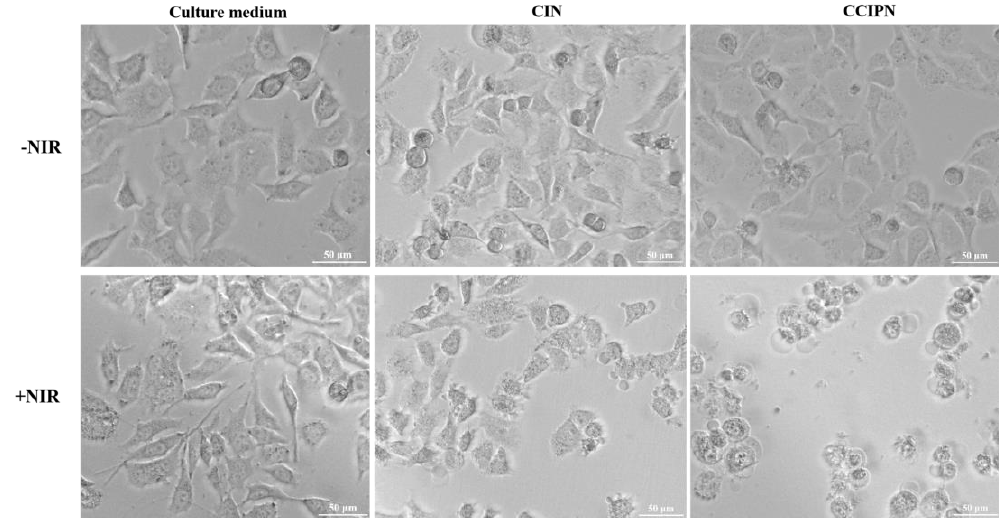
Figure 15. PC-3 cell morphologies after receiving different treatments in hypoxic condition.